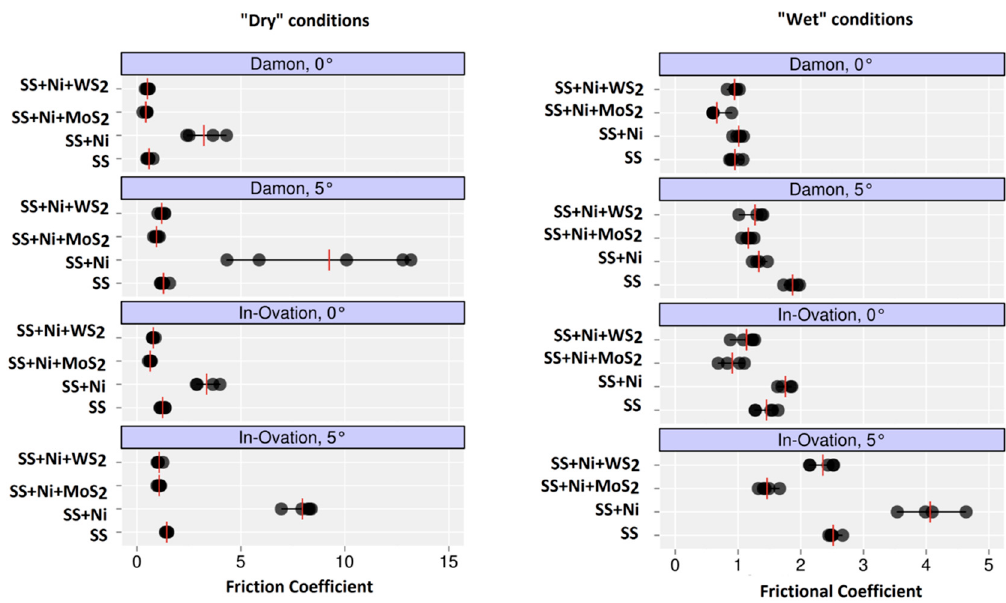
Figure 6. Statistical analysis.